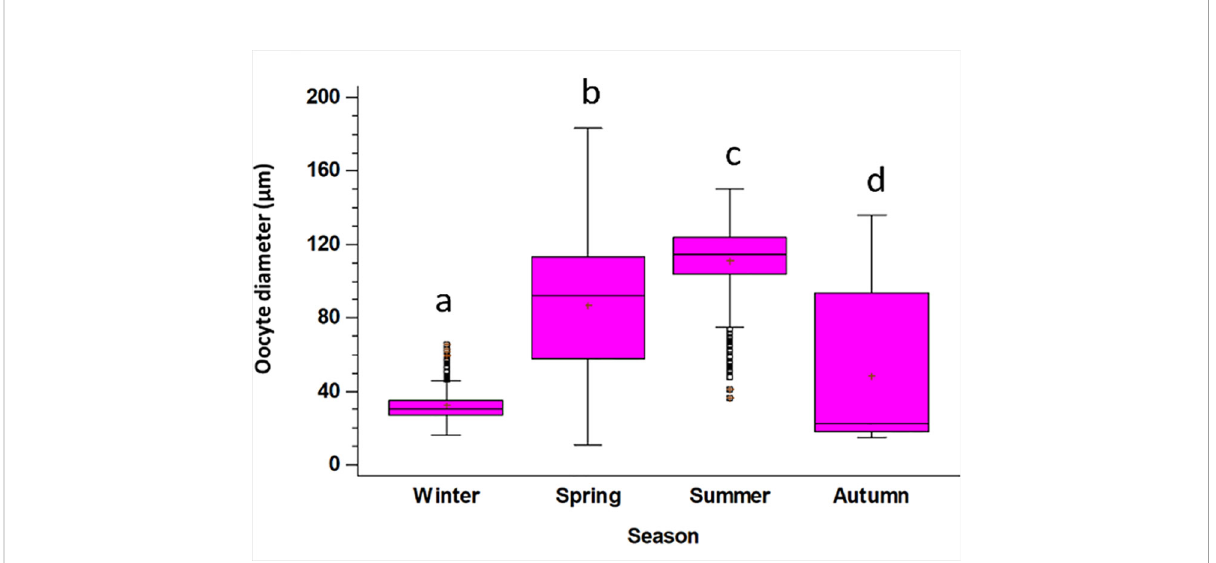
FIGURE 10 Oocyte diameters in the different seasons (Winter, January - March; Spring: April - June; Summer: July - September; Autumn: October - December). The boxes show the interquartile range, with the median value indicated by the horizontal line and the ‘ + ’ sign indicating the mean; whiskers show the range. Individual symbols show outliers. Lowercase letters indicate the results of the pairwise comparison between the oocytes size in different